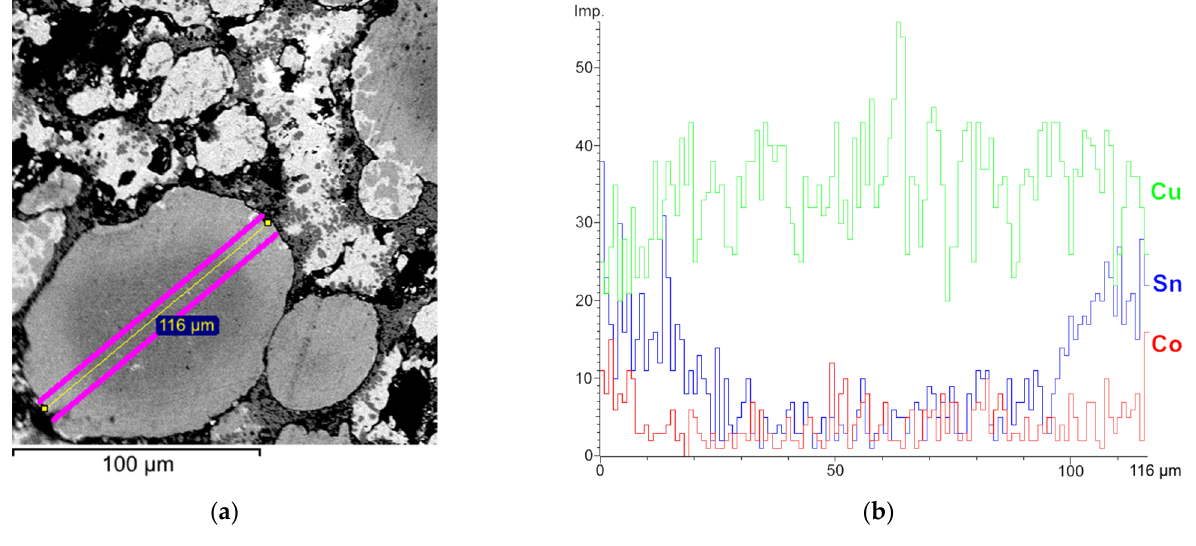
Figure 3. Particle of copper powder in a material sintered at 700 °C ( a ) and distribution of elements in the cross section of the particle ( b ).